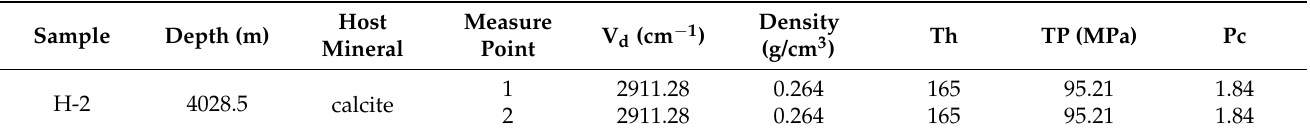
Table 1. Analysis and calculation results of representative methane inclusions in fibrous calcite vein from Well H-2 in the Southern Sichuan Basin.